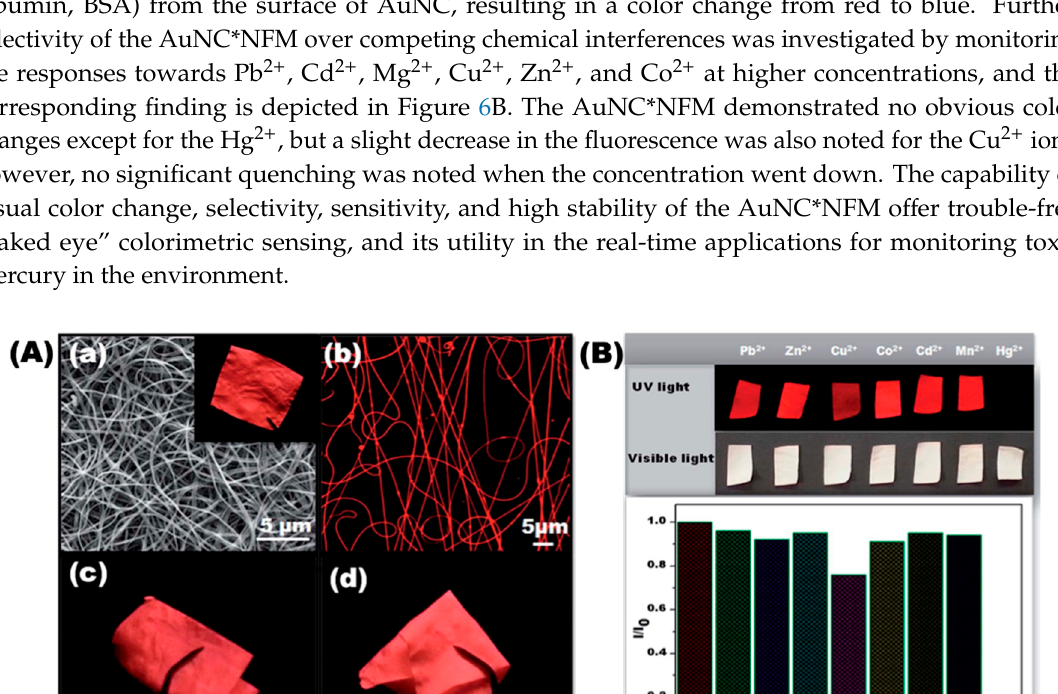
9 of 17 Figure 5. ( a ) Schematic illustration of a probe filter microfluidics system for real-time metal-ion sensing using an electrospun nanofiber membrane. ( b ) Relative conductivity versus time of the prepared Hg 2+ solution in the microfluidics system. Reprinted with permission from [42]. Copyright 2017, American Chemical Society. In continuation to the progress of developing nanofiber based Hg 2+ sensor, Senthamizhan et al. fabricated a polyvinyl alcohol (PVA) nanofibrous membrane (NFM) embedded with highly- luminescent gold nanoclusters (AuNC) named AuNC*NFM for Hg 2+ detection [44]. The nanofibrous sensor strip was designed based on certain criteria, including (1) fine homogeneity of AuNC in the nanofibers, (2) stability across time and temperature, (3) insoluble nature in water, (4) specific response to Hg 2+ , and (5) significant visual colorimetric detection. The PVA polymer matrix was selected for its hydrophilicity, electrospinnability, compatibility, and nontoxicity characteristics. The PVA nanofibrous mat was cross- linked with the glutaraldehyde (GA) vapor to convert the mat to being water-insoluble. The AuNC*NFM demonstrated excellent long-term stability and preserved its fluorescence characteristics up to 100 °C, which does not affect the sensing performance during real-time application. Figure 6A demonstrates the morphology, fluorescent characteristics, and flexible nature of the AuNC*NFM. The contact mode approach was employed for the visual detection of Hg 2+ through exposure to various concentrations, and the results demonstrate that the composite nanofibers are capable of detecting Hg 2+ with a detection limit of 1 ppb. Since the nanofibers possess a larger surface area, which facilitates the rapid adsorption of the Hg 2+ ions—that leads to desorption of capping molecules (bovine serum albumin, BSA) from the surface of